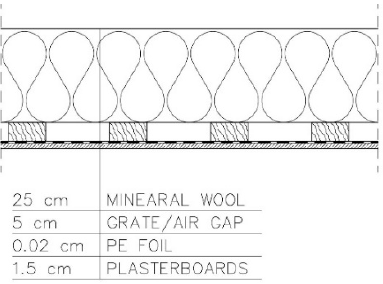
Figure 3. Variant 1: PE foil under the grate for fixing plasterboards. Roof ventilation equal to 20 changes per hour.